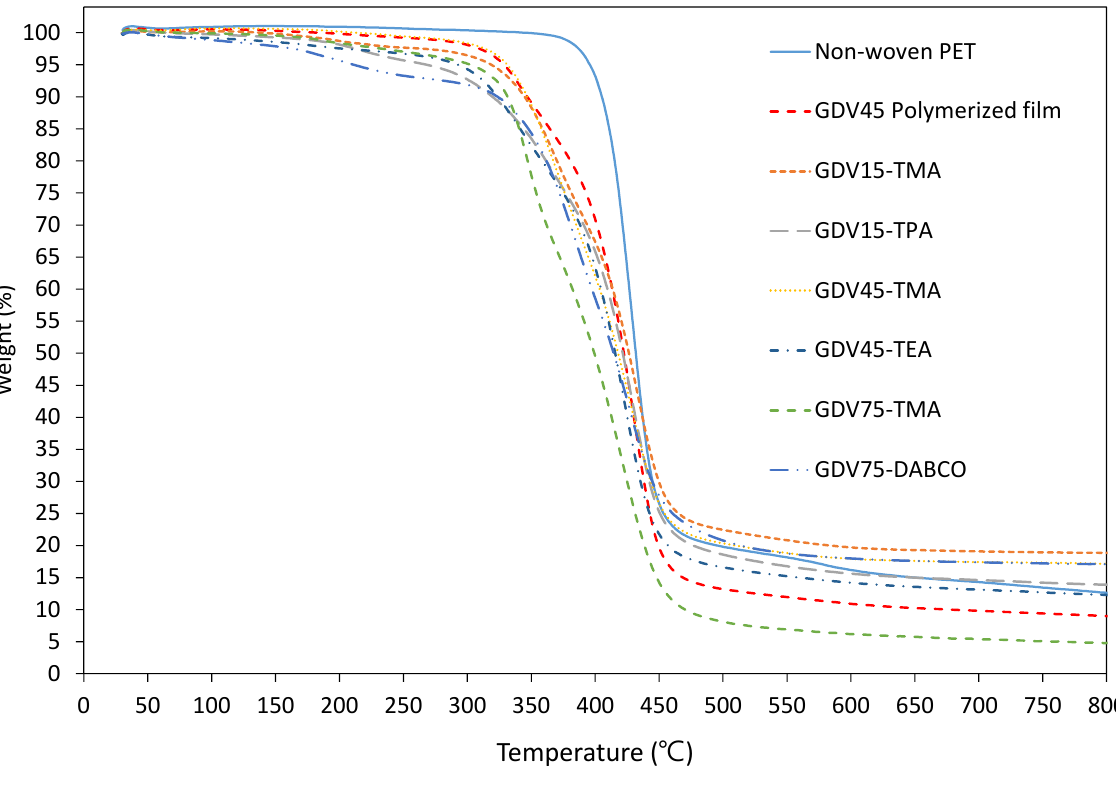
Figure 7. TGA (thermo gravimetric analysis) curves for the Non-woven PET, GDV45 base membrane, GDV15-TMA, GDV15-TPA, GDV45-TMA, GDV45-TEA, GDV75-TMA, and